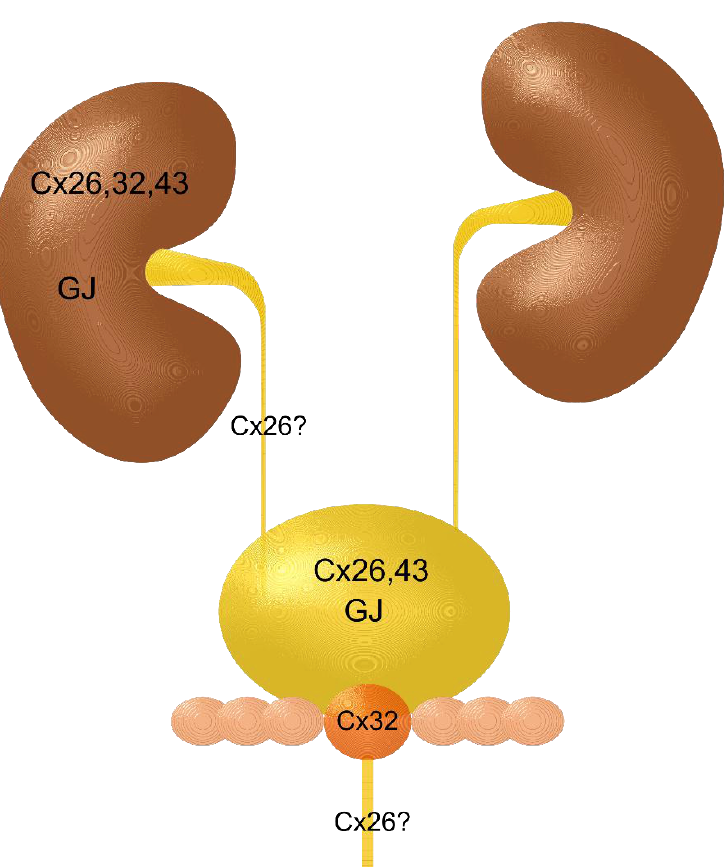
Figure 4. Schematic drawing of the urinary tract including kidneys, ureters, urinary bladder, prostate gland, seminal vesicles, and urethra. The drawing depicts the recently gathered data on connexins and gap junctions in the parts of the urinary tract.